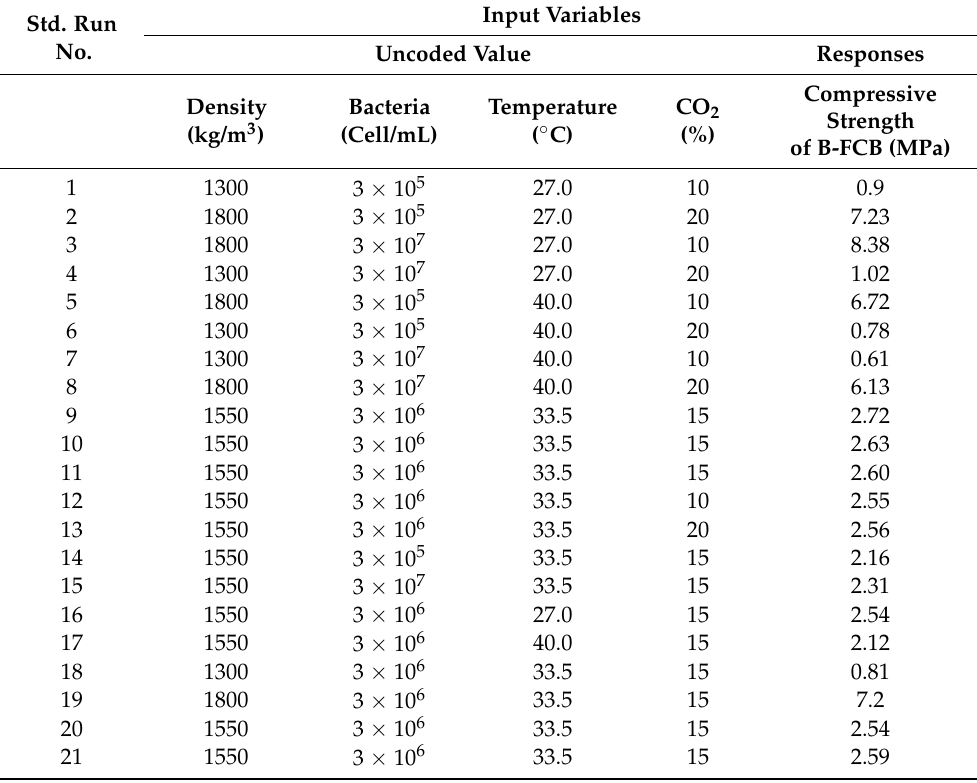
Table 7. Results of the full design of RSM for compressive strength and carbonation depth. Std.